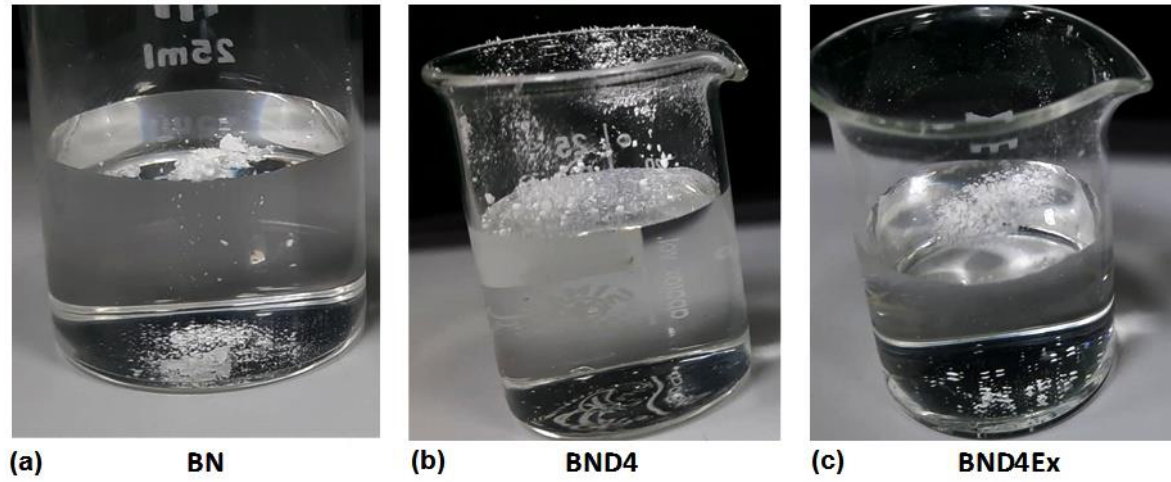
Figure 4. Images revealing the behavior, on contact, with water of the pristine BN powder ( a ) or treated differently: with D4 ( b ) and exfoliated after hydrophobization with D4 ( c ). As can be seen, the untreated BN on which the water drop is spread immediately or the powder is deposited immediately on the bottom of the glass, BND4 remains on the surface of the water for a long time, and the water drop remains spherical on its surface. Subtracted BND4-BN spectrum (Figure 2a) confirms the presence of D 4 on the BN surface. However, due to the polar structure of BN, nanosheets tend to stack as the TEM images them into the polymer matrix. As a result, in the third approach, BND4 was subjected to exfoliation by ultrasonication in isopropyl alcohol, resulting in BND4Ex. The presence of D 4 after hydrophobization (BND4) and exfoliation (BND4Ex) pro- cesses was highlighted by the difference of the spectra (Figure 2a) (subtract spectra func- tion), while the hidden and overlapped peaks of the BN, BND4, and BND4Ex in the 1650–830 cm − 1 were found by using the second derivative of the spectra (Figure 2b). The vertical dashed lines highlight the spectral changes after the applied treatments on BN 762 cm − 1 , assigned to the B-N stretches ( h BN). The subtracted IR spectra (subtract